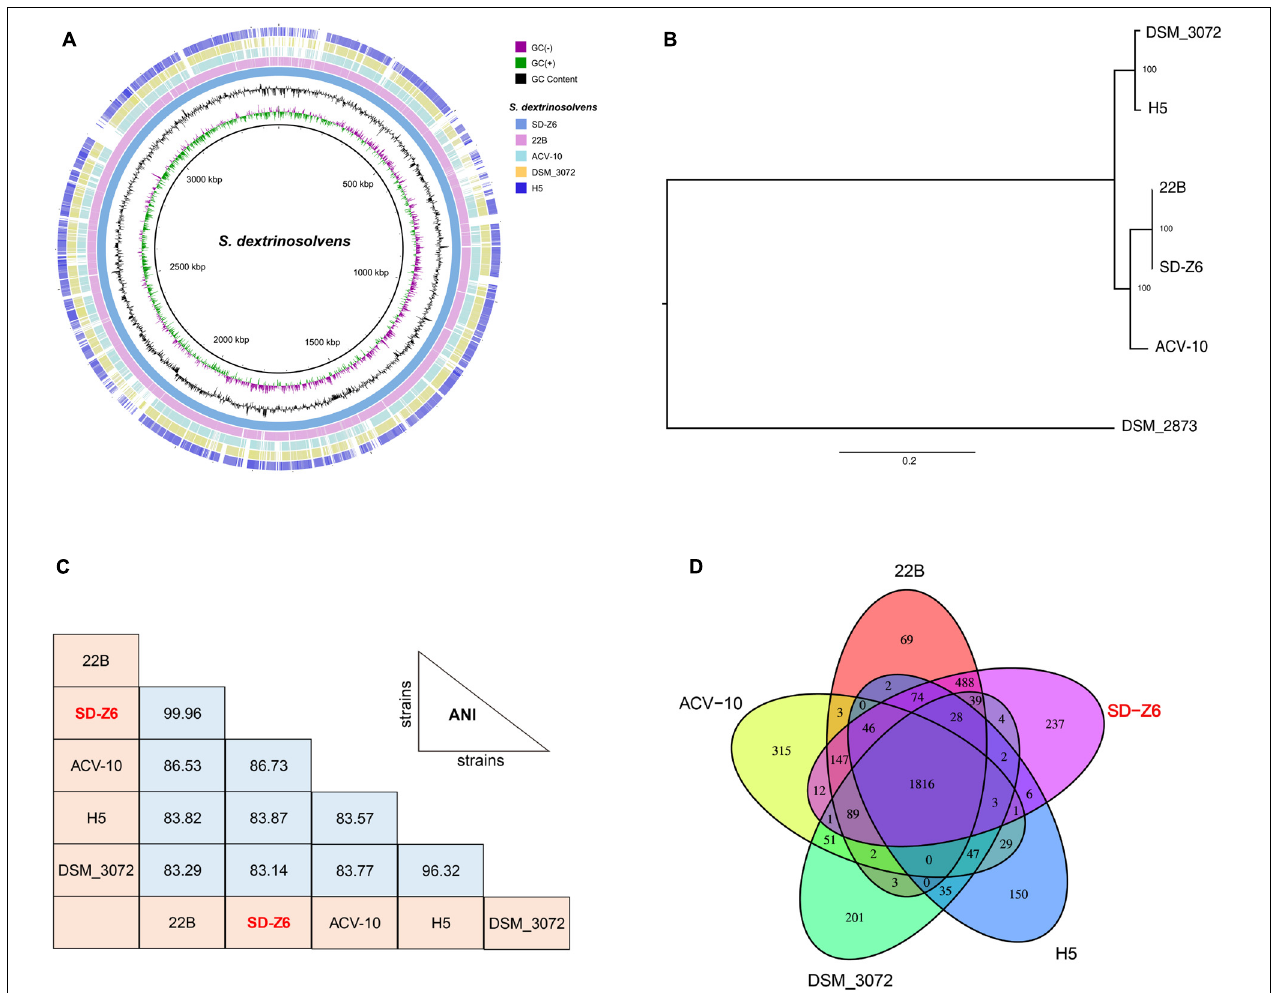
FIGURE 2 | Comparative genome analysis of Succinivibrio dextrinosolvens strain Z6 and closely related strains. (A) BLAST Ring Image Generator (BRIG) analysis of S. dextrinosolvens strain Z6 and the genomes of S. dextrinosolvens 22B, S. dextrinosolvens ACV-10, S. dextrinosolvens H5, and S. dextrinosolvens DSM_3072. The innermost ring represents the skew (- and +), followed by GC content. The third ring shows S. dextrinosolvens strain Z6 (blue), ring 4 S. dextrinosolvens 22B (pink), ring 5 S. dextrinosolvens ACV-10 (light blue), ring 6 S. dextrinosolvens DSM_3072 (yellow), and ring 7 S. dextrinosolvens H5 (dark blue). (B) Phylogenetic tree highlighting the relationship of S. dextrinosolvens strain Z6 with other strains in the Succinivibrio genus. The evolutionary history was inferred using the maximum likelihood method and showed that S. dextrinosolvens Z6 is a member of the Succinivibrio genus. The percentage of trees in which the associated taxa clustered together is shown next to the branches. Succinimonas amylolytica DSM_2873 is an outgroup. (C) Pairwise comparisons of average nucleotide identity (ANI), and (D) global gene conservation in Succinivibrio . Each oval represents the total number of genes in each genome. Overlapping regions depict the number of genes shared between the respective